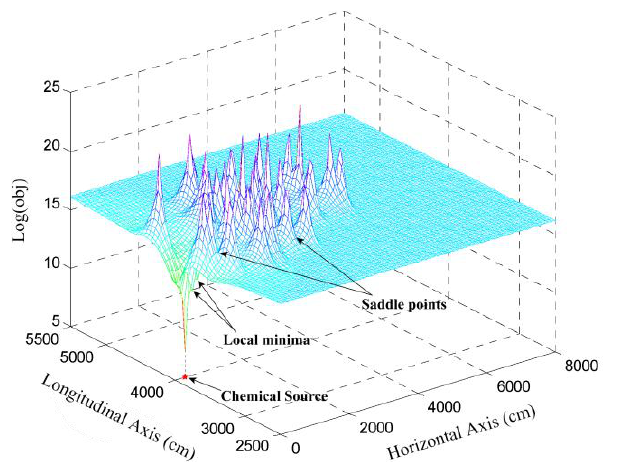
Figure 2. Mesh graph of the objective function in Equation (13); the actual source is located at (3,40) m. The unit of the objective function is ppm 2 . Some of the local minima and the saddle points are pointed out. More details about the simulation setup are given in Section 4.